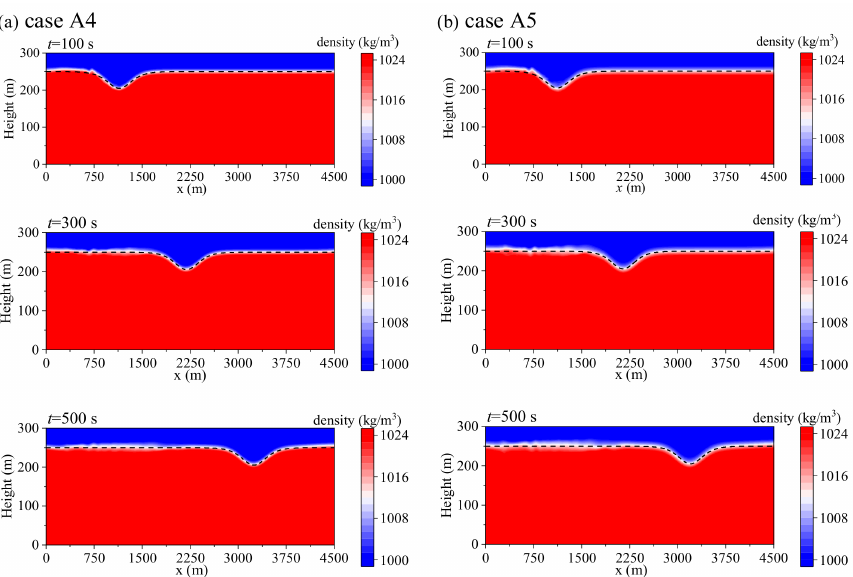
Figure 8. Density distribution of ISWs for: ( a ) Cases A4; ( b ) Case A5.